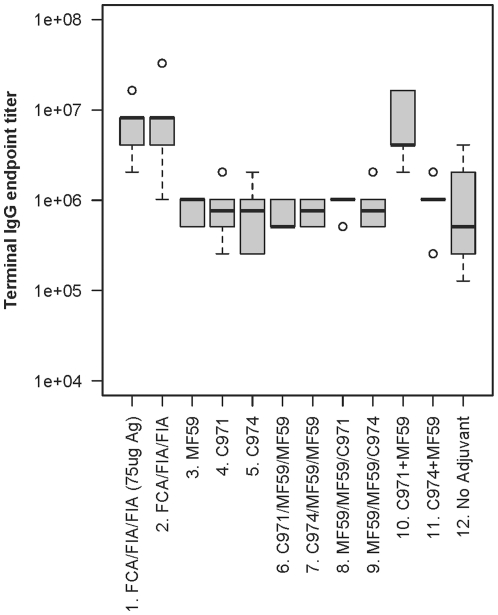
Endpoint IgG binding titer.The antigen-specific IgG titer was measured by ELISA. Antiserum (terminal time point) was serially diluted (2-fold) and the endpoint titer was defined as the last dilution that gave a positive signal (>3-fold signal of the prebleeds). Animals that received the FCA/FIA (groups 1 and 2) or combination of Carbopol-971P and MF59 have significantly higher endpoint IgG titers than others (p<0.05).